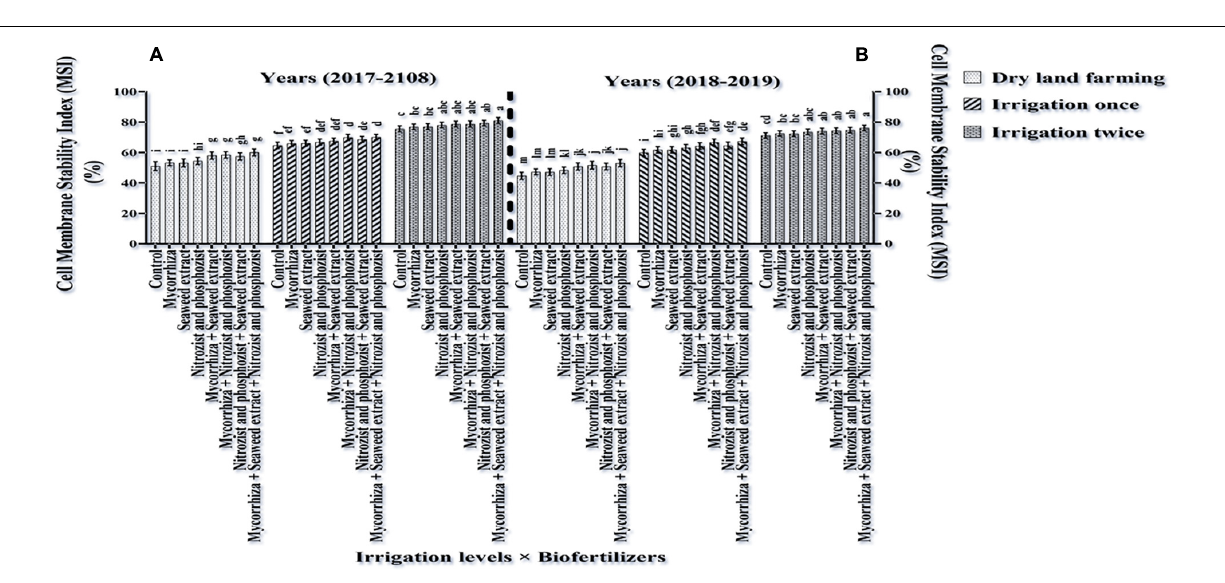
FIGURE 10 | Mean comparisons of the dual interaction effect of irrigation × biofertilizers on cell MSI in wheat plant in two seasons of experiment (A,B) (2017–2018 and 2018–2019). Means in each column followed by similar letter(s) are not significantly different at 1% probability level by the LSD